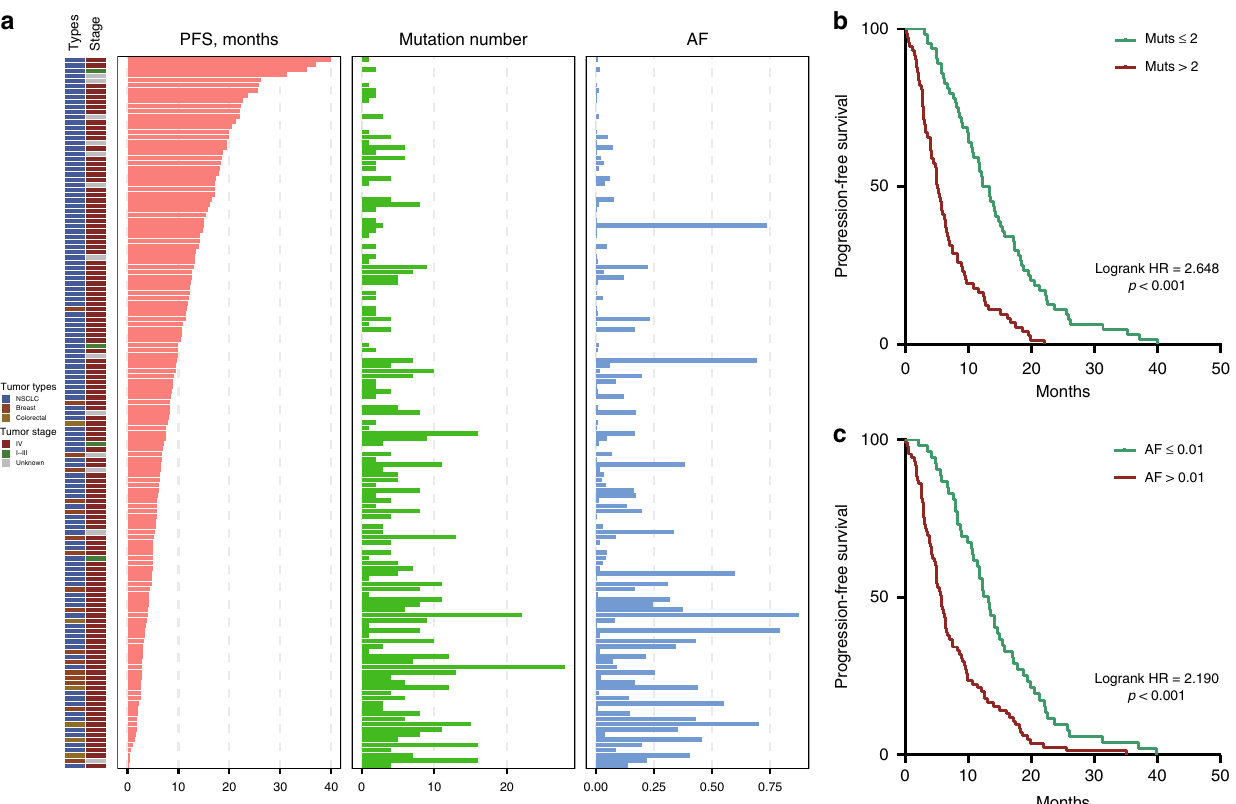
Fig. 7 Circulating tumor burden determined by ctDNA pro fi ling is associated with therapeutic prognosis. a Overview of tumor types, clinical stages, PFS, ctDNA mutation numbers, and ctDNA AFs for 137 patients receiving targeted therapies guided by ctDNA pro fi ling. b Patients with >2 mutations in ctDNA exhibited poorer PFS than those with ≤ 2 mutations in ctDNA. c Patients with >0.01 ctDNA AF exhibited poorer PFS than those with ≤ 0.01 ctDNA